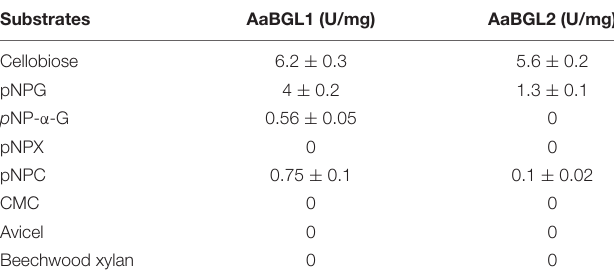
TABLE 2 | Substrate specificities of AaBGL1 and AaBGL2.